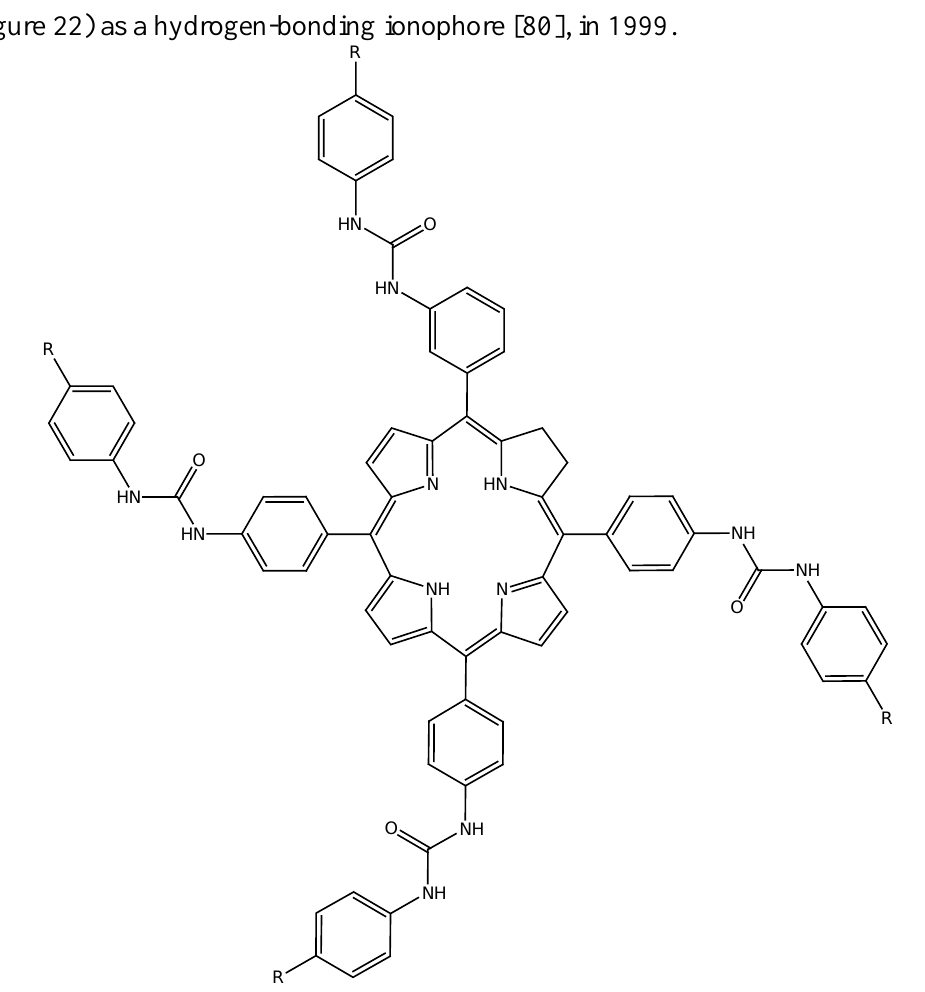
Figure 22. Urea-functionalized porphyrin (R = F or